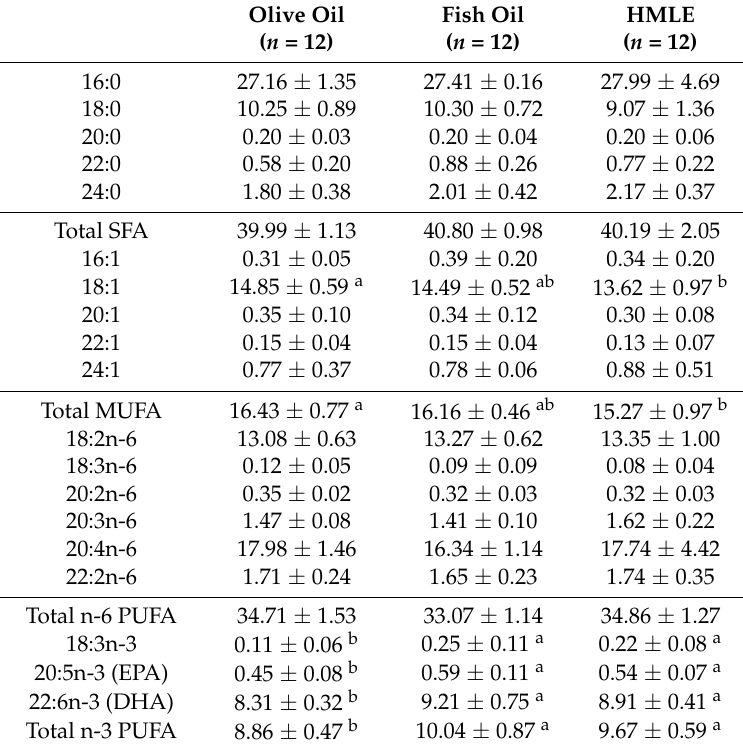
Table 2. Effects of different gavage treatments on mice erythrocyte phospholipid fatty acid composition.